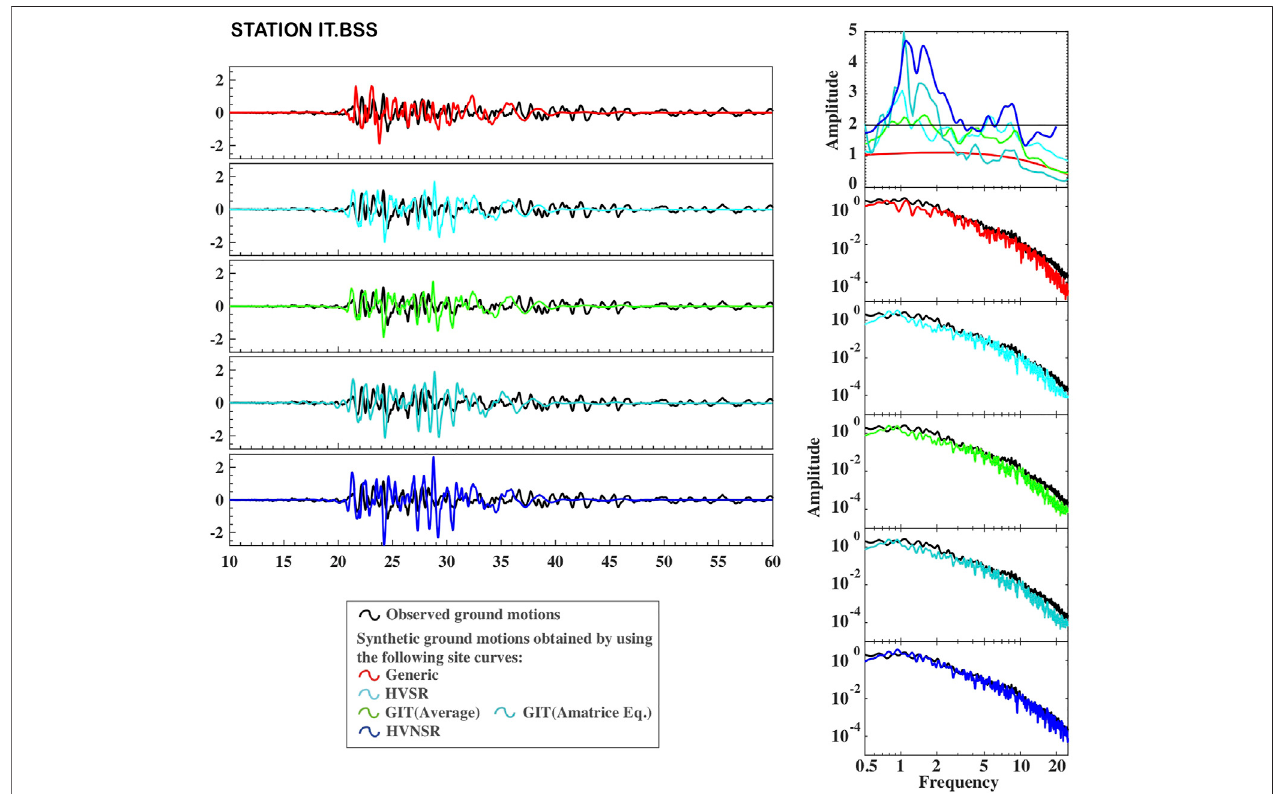
FIGURE2| Exempli fi cationsimulation resultsat stationBSS(Bussi),belongingtotheITnetwork.Theleft-toppanelshowsampli fi cation curves appliedastheterm G(f)intheEXSIMcodeusedforstochasticsimulations( Eq.5 ).TheredcurveisthegenericonethatweusedforallclassBsitesde fi nedinNTC-18basedontheV s30 value (see also Supplementary Figure S3 ). The other tested site-empirical speci fi c curves are: the cyan curve is the HVSR calculated using earthquake weak motion (S waves); the green and turquoise curves are the GIT-derived ampli fi cation function by using 455 earthquakes and only the Amatrice earthquake, respectively (Morasca et al., 2022); the blue curve is the HVNSR calculated using ambient noise or earthquake coda waves. Synthetic hybrid broadband horizontal component velocity time histories (left panel) and Fourier velocity amplitude spectra (top-right panel) are compared with the recorded ground motions (black lines). For the latter, we calculated the geometric mean, and mean of the two horizontal components of ground motion, respectively, for time histories and Fourier spectra.